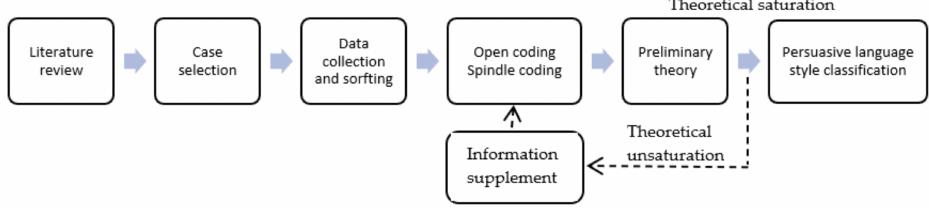
Figure 2. Research procedure based on grounded